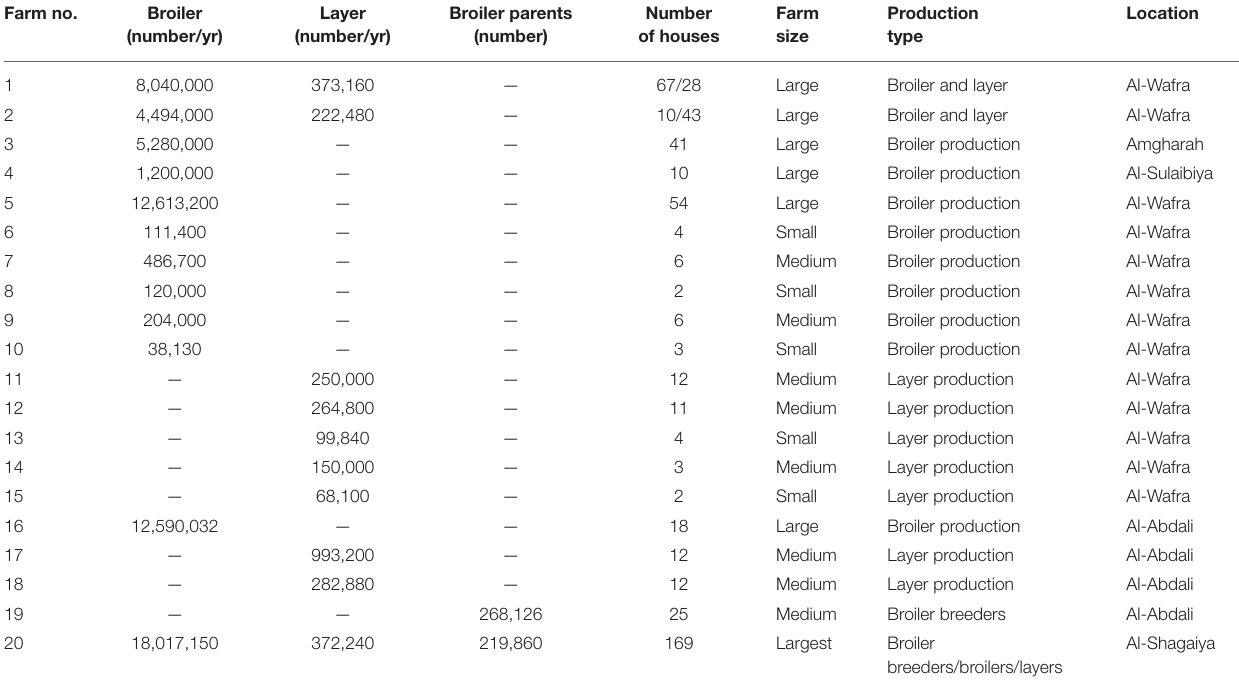
TABLE 1 | List of specialized poultry farms that belong to the eight poultry companies in Kuwait. Farm no.